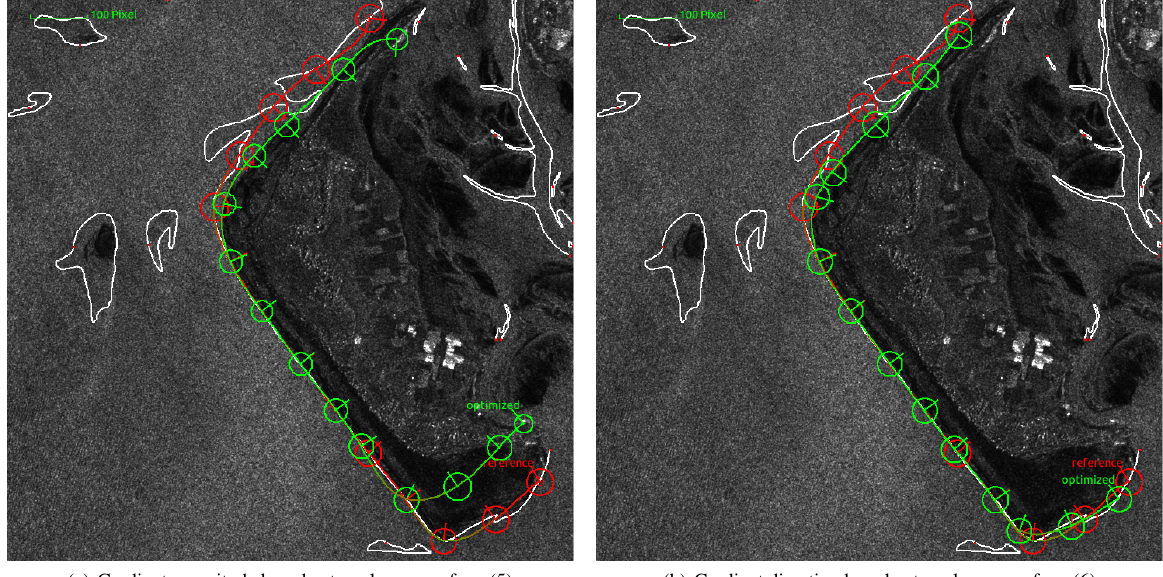
Figure 4: Two resulting views of the proposed framework using different external energy terms and and an initialization using S-57 ENCs. The zero-level waterlines are printed in white. The initial snake is printed in red, whereas the finally optimized snake is printed in green. The positions of the control points are marked by circles, whereas lines visualize the user-defined normal directions at the control points. The changing color along one contour is caused by the varying inner tension due to the inner energy definition of the snake. Further information about the parameters are given in section